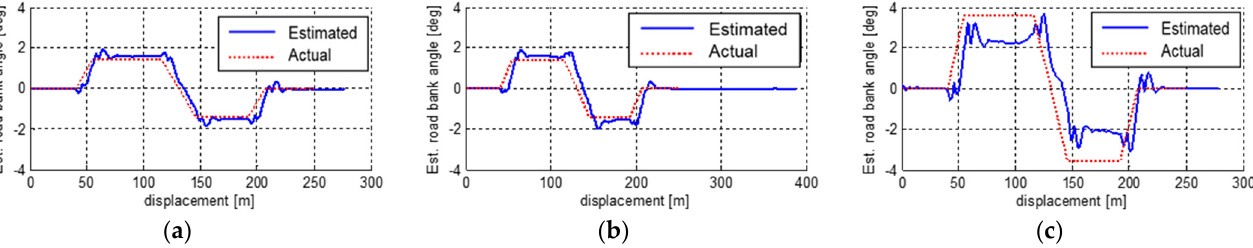
Figure 7. Estimated bank angle. ( a , b ) refer to the straight road with the bank angle condition, and ( c ) refers to the S-curve with the road bank angle condition.